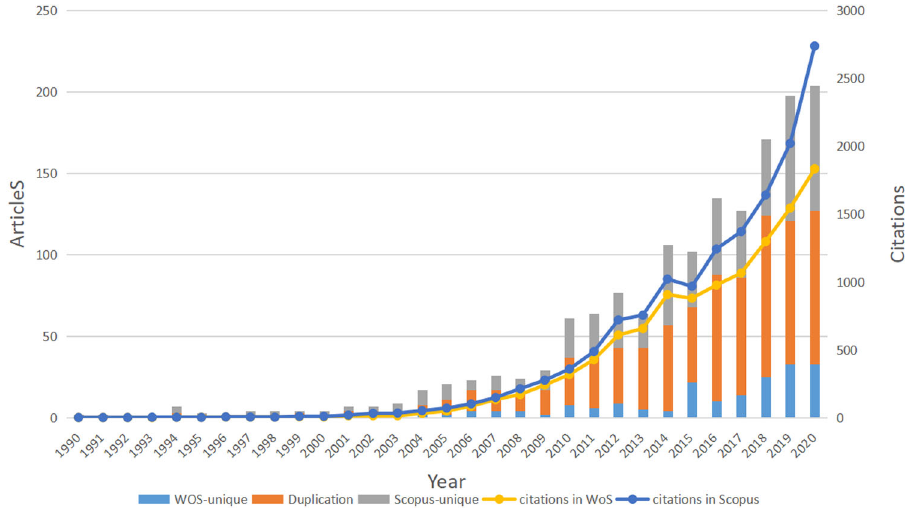
Fig. 1 Publication and citation outputs. The annual number of the literature relating to published articles and citations in oral health literacy research from 1990 to